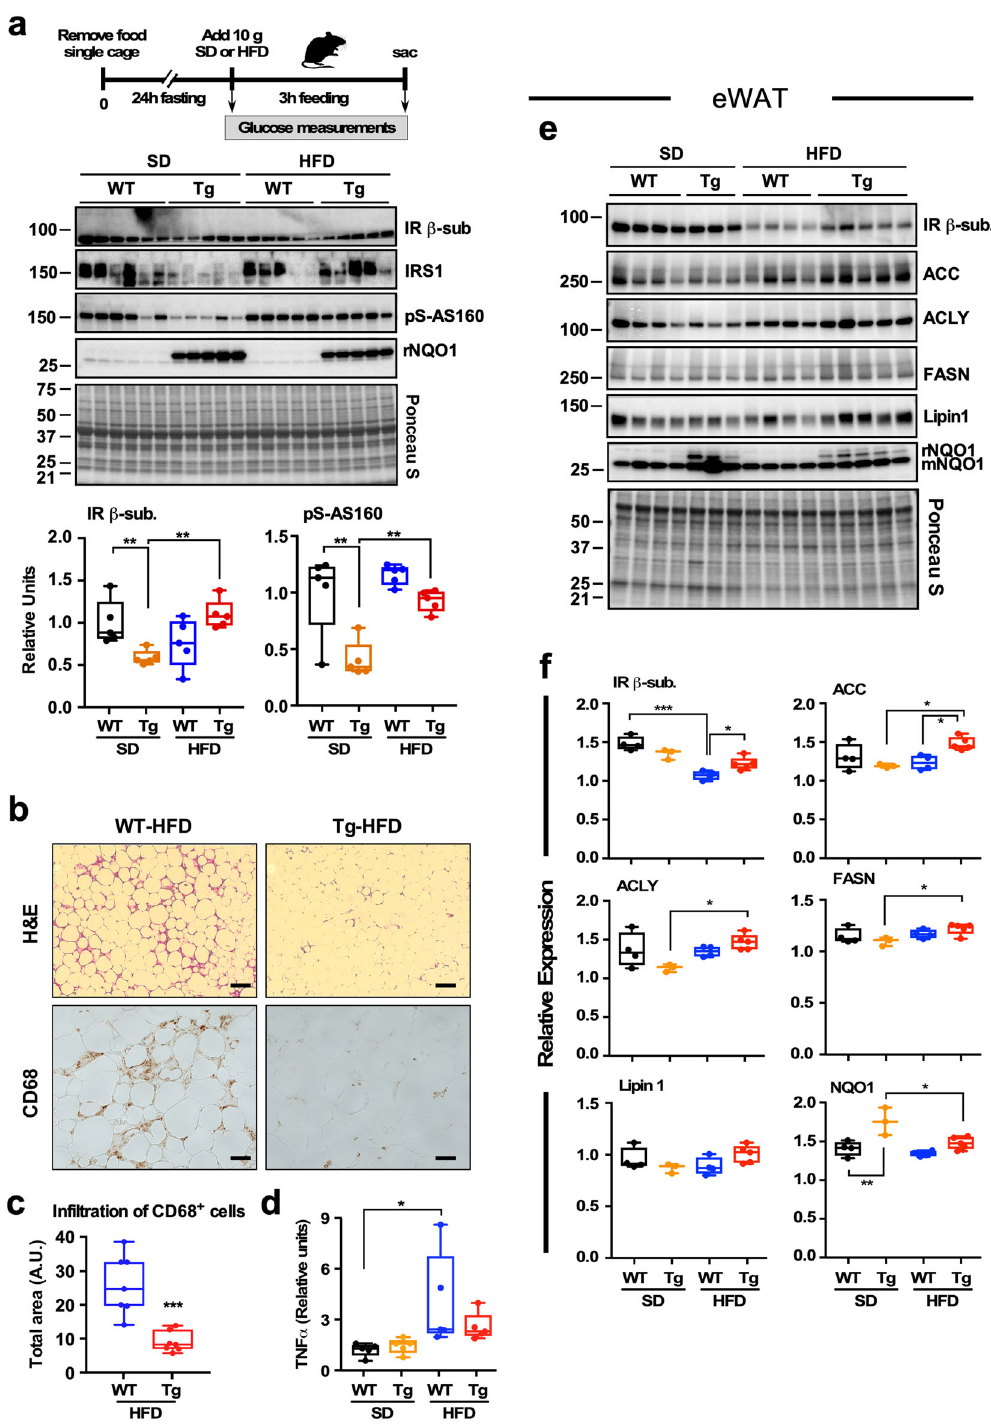
Fig. 3 Effect of global NQO1 transgenesis and diet composition on key players of insulin action in skeletal muscle and eWAT of mice. a Comparison of the 3-h refeeding period with SD and HFD on insulin receptor/IRS-1 pathway activation. Upper diagram illustrates the experimental protocol. Middle panel , immunoblots for IR β -subunit, IRS-1, serine phosphorylated AS160, and NQO1 from skeletal muscle homogenates. Note the marked accumulation of rat NQO1 transgene. Ponceau S staining of the membrane is shown and the molecular weight protein standards (kDa) are depicted on the left. Bottom panel , densitometric quanti fi cation of IR β -subunit and phosphorylated AS160. Values are represented as boxplots with individual values ( n = 5 per group). b Fixed adipose tissue from HFD-fed mice were H&E stained (top panels) and processed for expression of CD68 by immunohistochemistry (bottom panels). Each specimen was examined at the same magni fi cation. c Degree of fat cell in fi ltration by CD68 + cells, n = 7. d Relative TNF α mRNA levels in the liver determined by quantitative PCR, n = 4 – 5. e Immunoblots for IR β -subunit, ACC, ACLY, FASN, Lipin 1, and NQO1 from eWAT homogenates. Note the presence of the rat NQO1 transgene. f Densitometric quanti fi cation of the immunoblots depicted in e , n = 3 – 5. *, **, *** p < 0.05, 0.01,